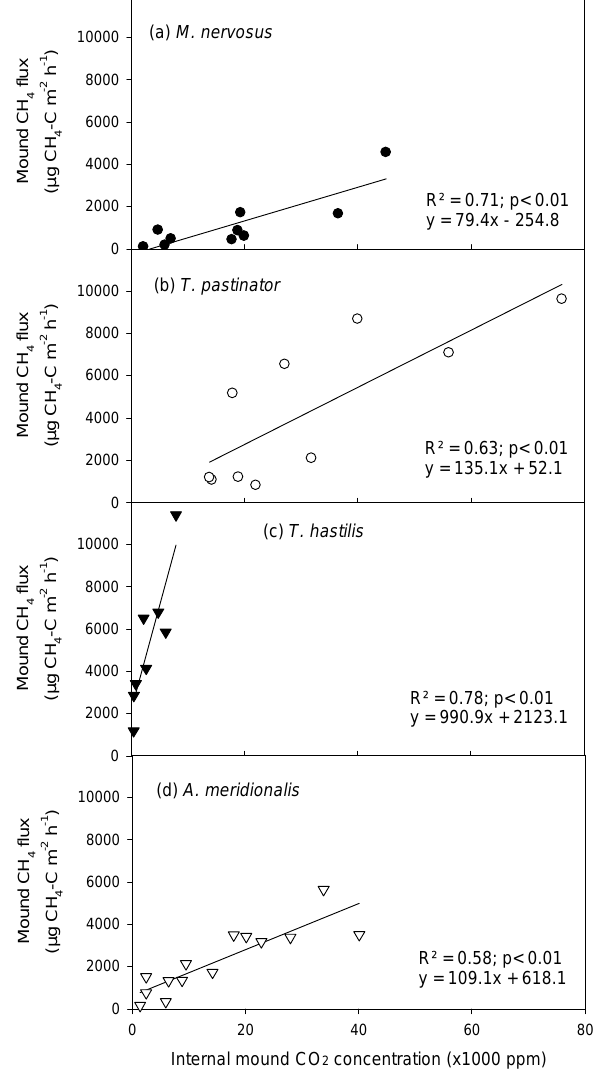
Figure 5: Relationship of mound CH 4 flux and CO 2 concentration inside mound 693 Fig. 5. Relationships of mound CH 4 flux and CO 2 concentration inside mound.